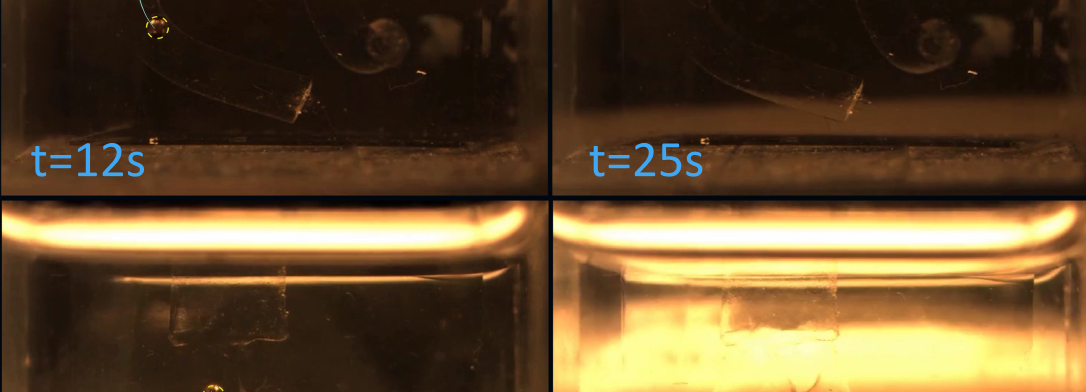
Figure 5. Representative timelapse of the experiments. In the first image, yellow, green, and red dashed lines mark the outline of the channels in the phantom. A yellow dashed line is also used to highlight the position of the microrobot in the frames. The blue arrows approximate the future trajectory of the microrobot. The microrobot starts from the end of the yellow-outlined channel, and navigates to the end of the green one, where it releases the drug-model. Finally, the microrobot returns to the starting point. Moreover, the changes in position of the ultrasound transducer, continuously sweeping through the workspace, can be noticed in the background. Please, refer to the accompanying video for the visualization of the experiment in the Supplementary